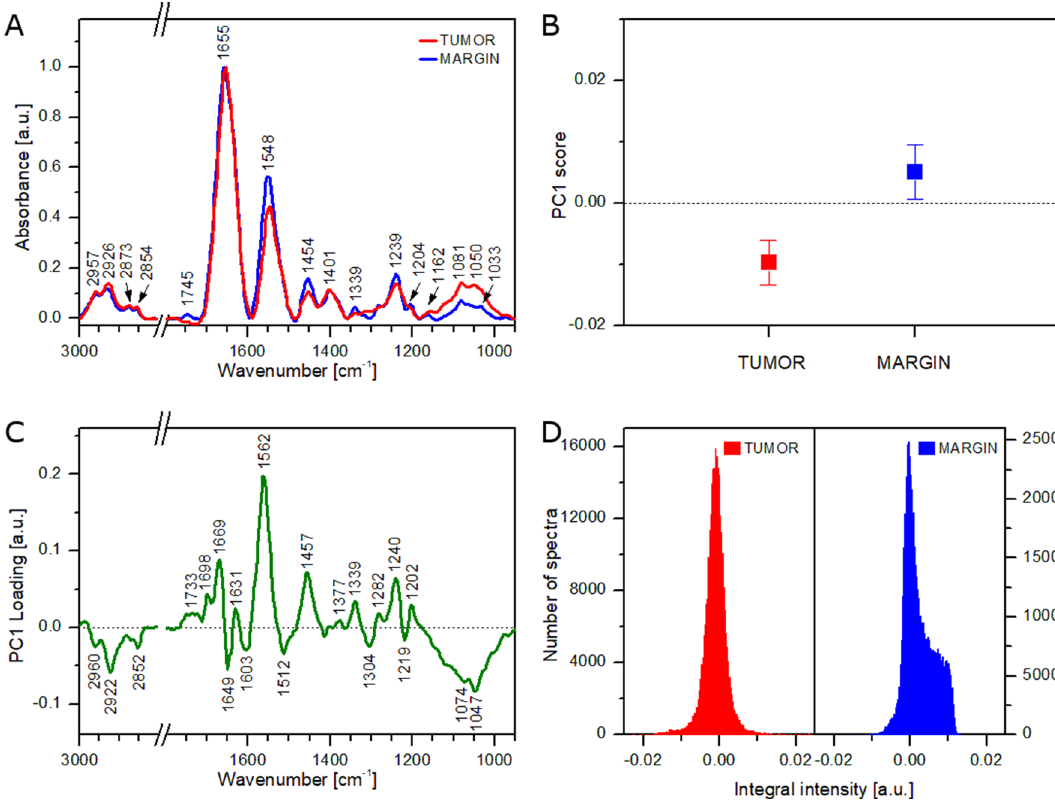
Figure 4. Results of FT-IR analysis of tumoral tissue and healthy margin without spectra showing lipid bands of high intensity: average FT-IR spectra ( A ), mean values of PC1 score ( B ), PC1 loading plot ( C ), histograms showing the distribution of integral intensity of the 1746 cm −1 band ( D